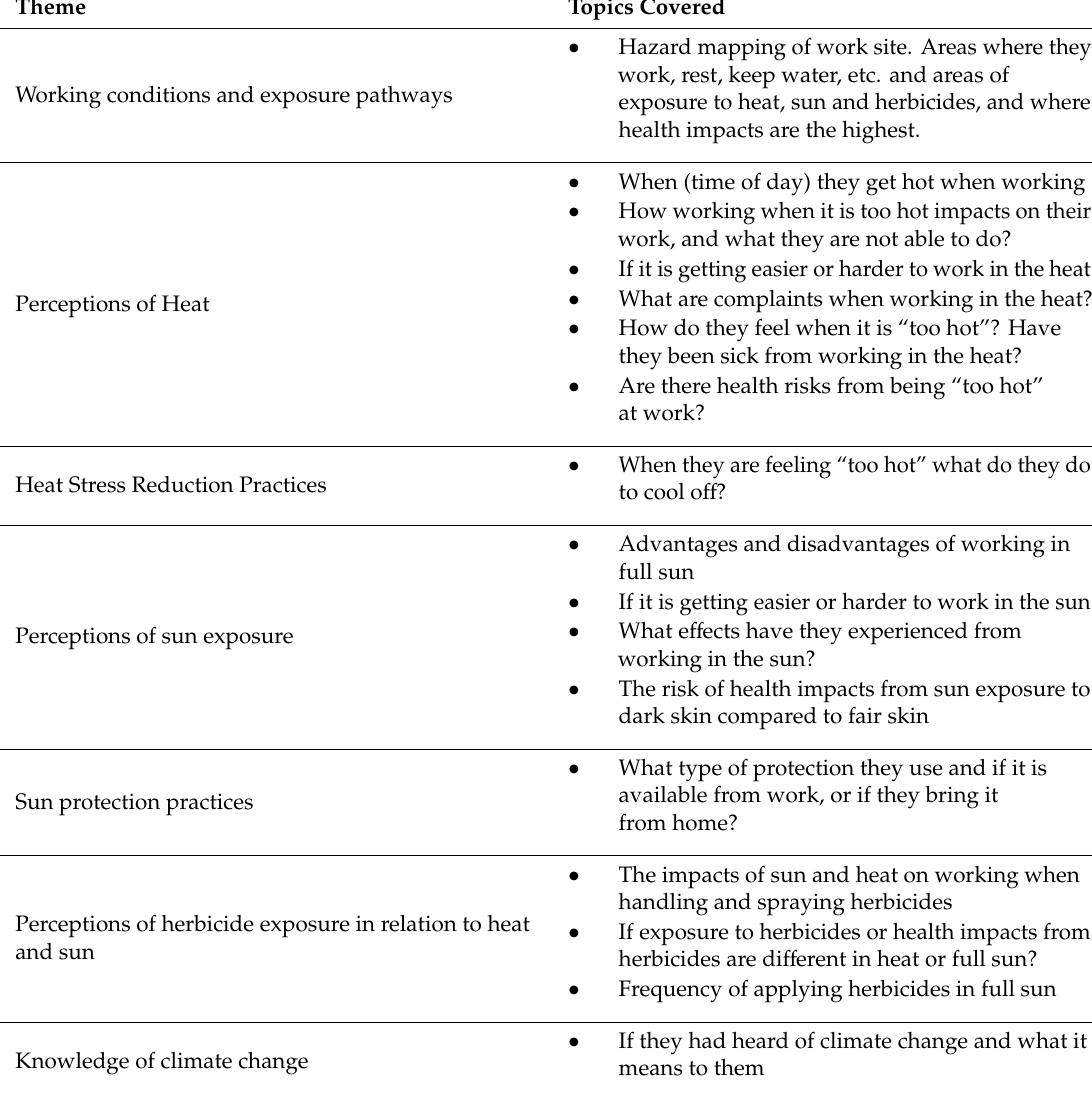
Table 1. Topics covered per theme in the focus group